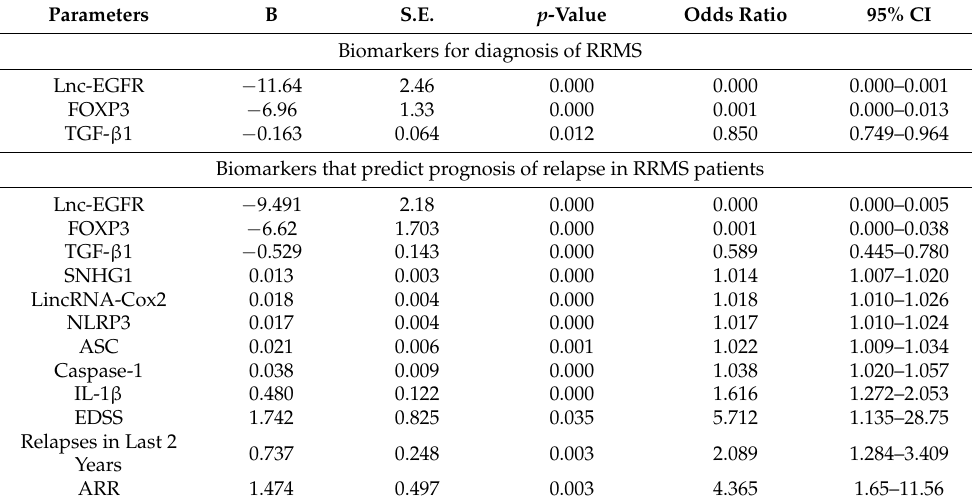
Table 4. Univariant binary logistic regression